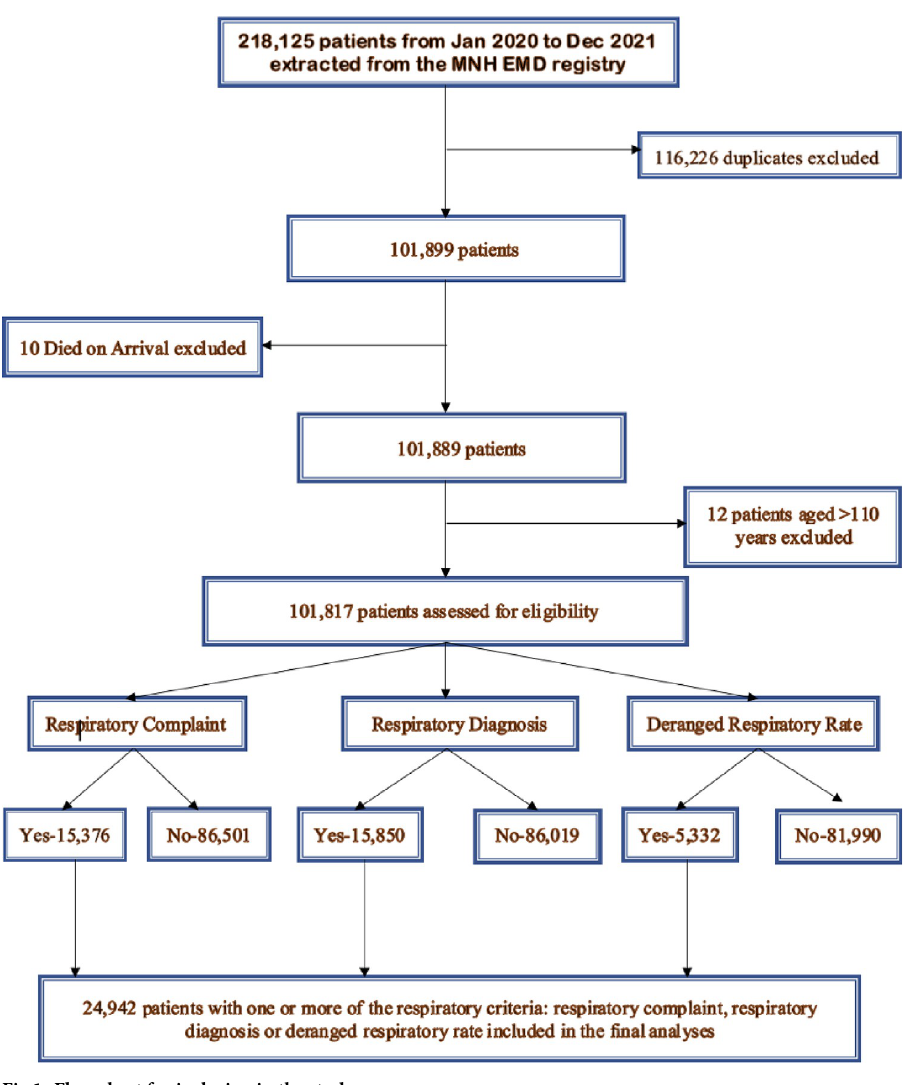
Fig 1. Flow chart for inclusion in the